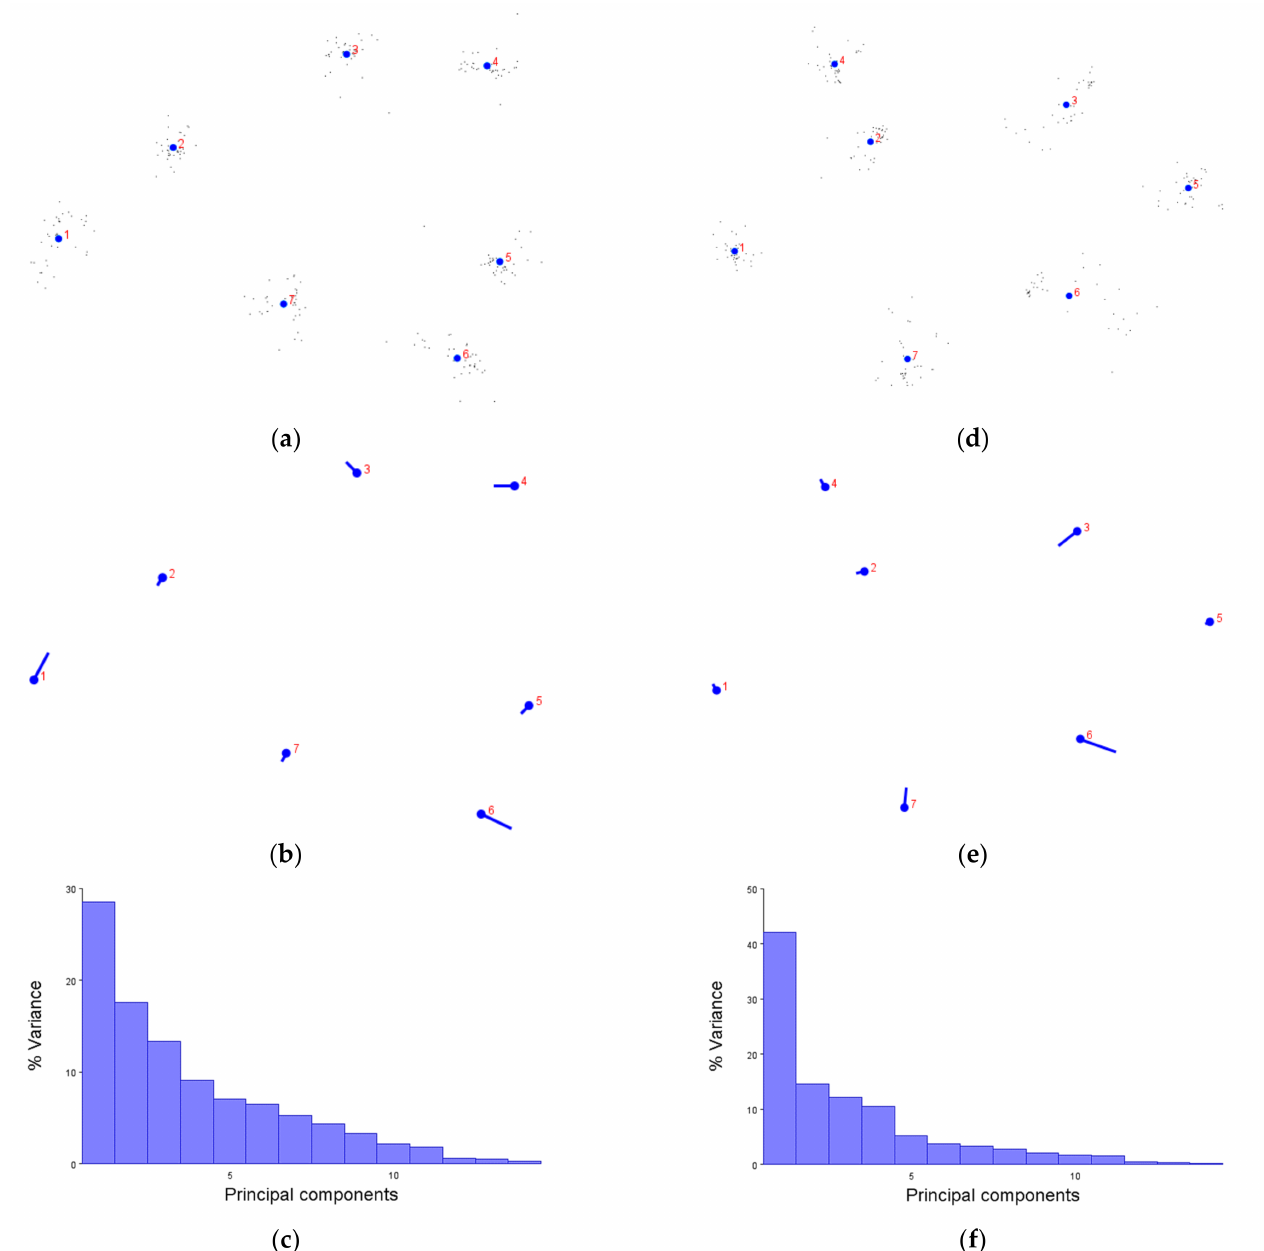
Figure A1. Supplementary graphs to support Figure 3. ( a ) Generalised Procrustese transformation, ( b ) PC1 variation and ( c ) eigenvalues for the extracellular face of the β 2AR receptors. ( d ) Generalised Procrustese transformation, ( e ) PC1 variation and ( f ) eigenvalues for the intracellular face of the β 2AR